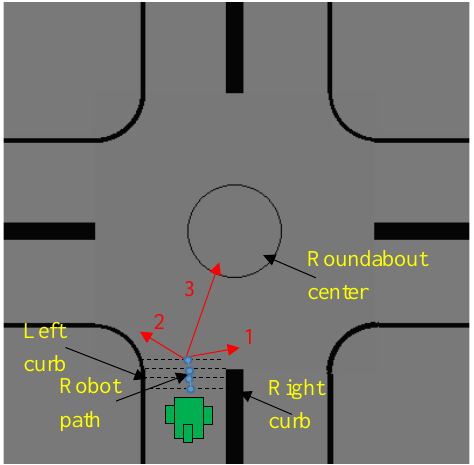
Figure 1. Conditions of the roundabout used for roundabout detection: (1) right curb is faded, (2) left curb is slightly faded, and (3) circular path is detected.